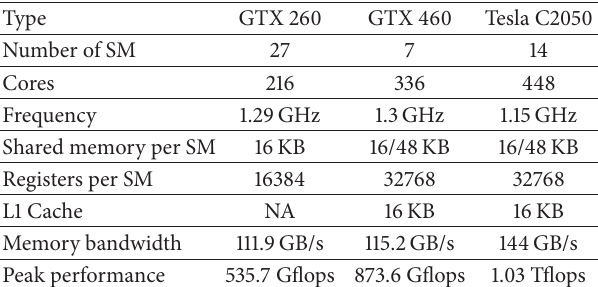
Table 4: The characters of